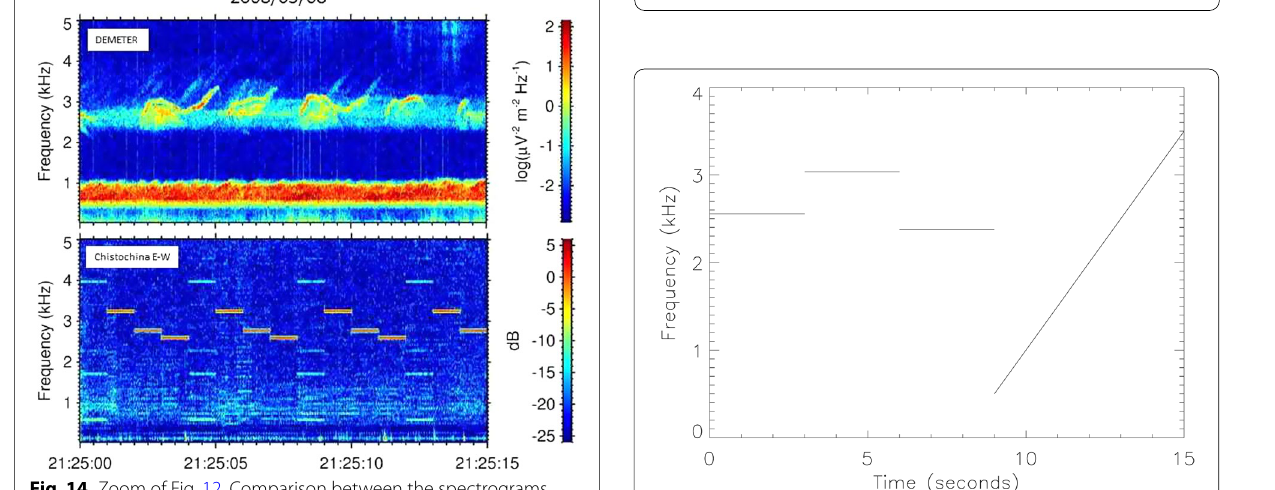
Fig. 15 Spectrograms recorded onboard DEMETER in the Southern hemisphere (top panel), and at Chistochina (bottom panel) between 21:53:00 and 21:59:20 UT in the frequency range 0–5 kHz. The power spectral density is color-coded according to the scale on the right